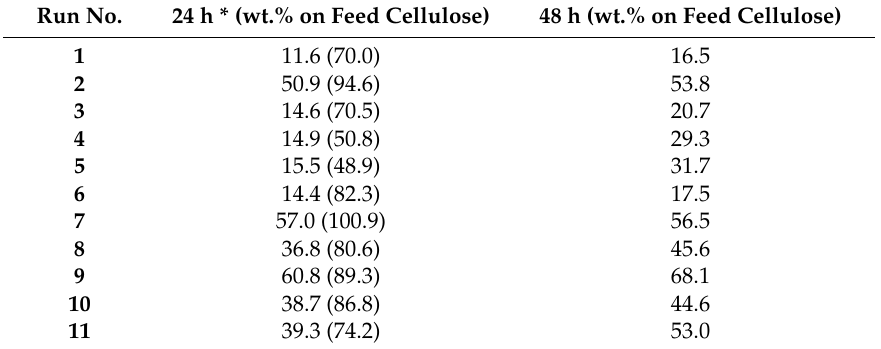
Table 4. Enzymatic hydrolysis to glucose at 24 and 48 h.